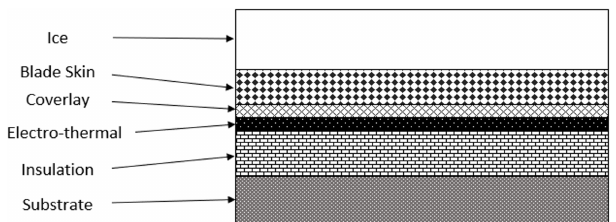
Figure 3. Simplified electro-thermal IPS